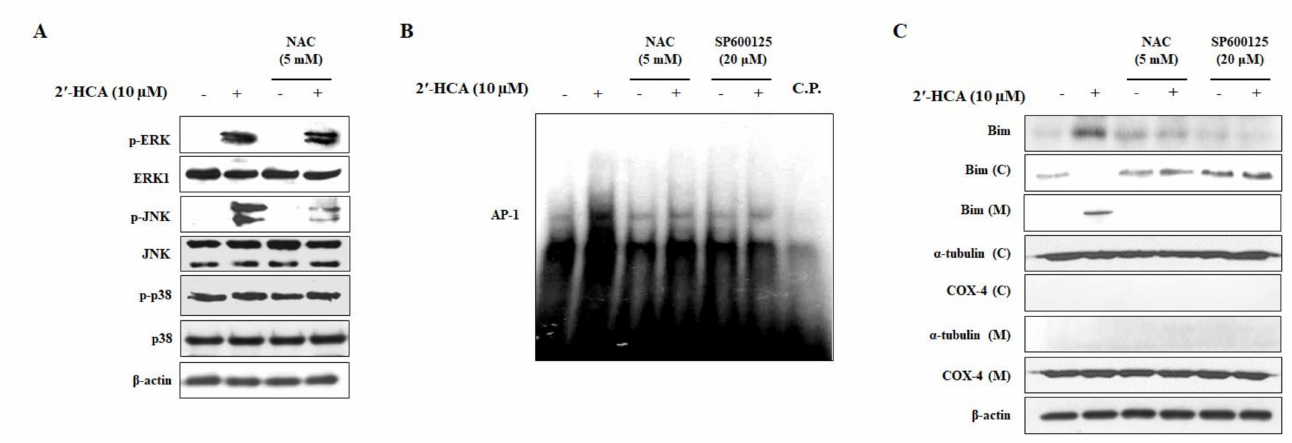
Figure 7. Effect of 2 (cid:48) -HCA-activated ROS on MAPK activation in HL-60 cells. ( A ) Representative western blots showing changes in the protein levels of p-ERK1/2, p-JNK, p-p38 MAPK, ERK1/2, JNK, and p38 MAPK after pretreatment with 5 mM NAC for 1 h followed by treatment with 10 µ M 2 (cid:48) -HCA for 8 h. β -actin was used as an internal control. ( B , C ) After pretreatment with 5 mM NAC or 20 µ M SP600125 for 1 h, HL-60 cells were treated with 10 µ M 2 (cid:48) -HCA for 8 h, and AP-1 DNA-binding activity and protein expression and translocation of Bim were analyzed by EMSA and western blotting, respectively. A competition experiment using a 5-fold excess of cold oligonucleotides (C.P.) indicated that DNA binding was specific. α -tubulin, COX 4, and β -actin were used as internal